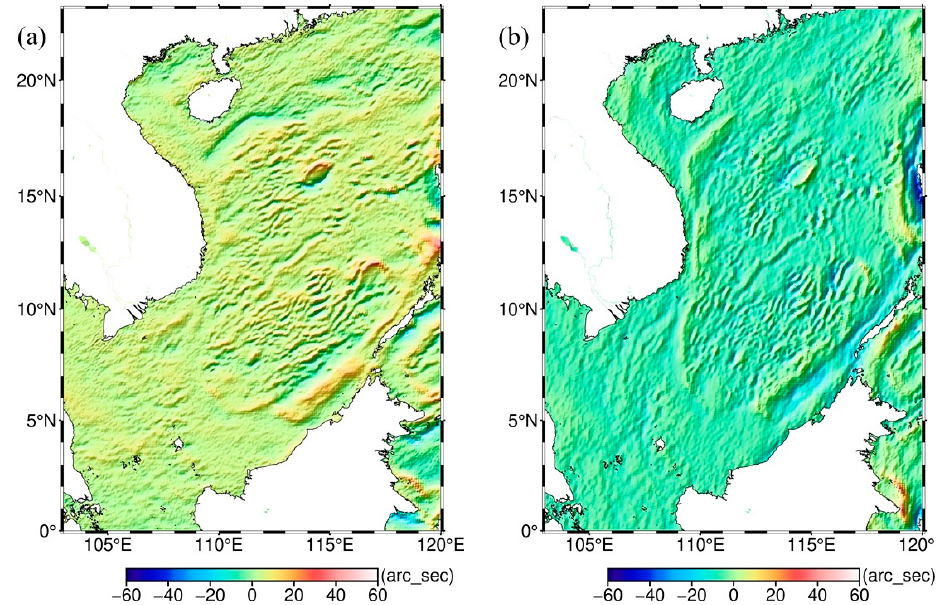
Figure 8. ( a ) The meridian component of the gridded DOV calculated by the ICESat-2 cross-beam DOV; ( b ) the prime vertical component of the gridded DOV calculated by the ICESat-2 cross-beam DOV. Table 13. Statistics of differences between gridded DOVs calculated by the cross-beam DOVs and the XGM2019e_2159-DOV model (Unit: arc_sec).